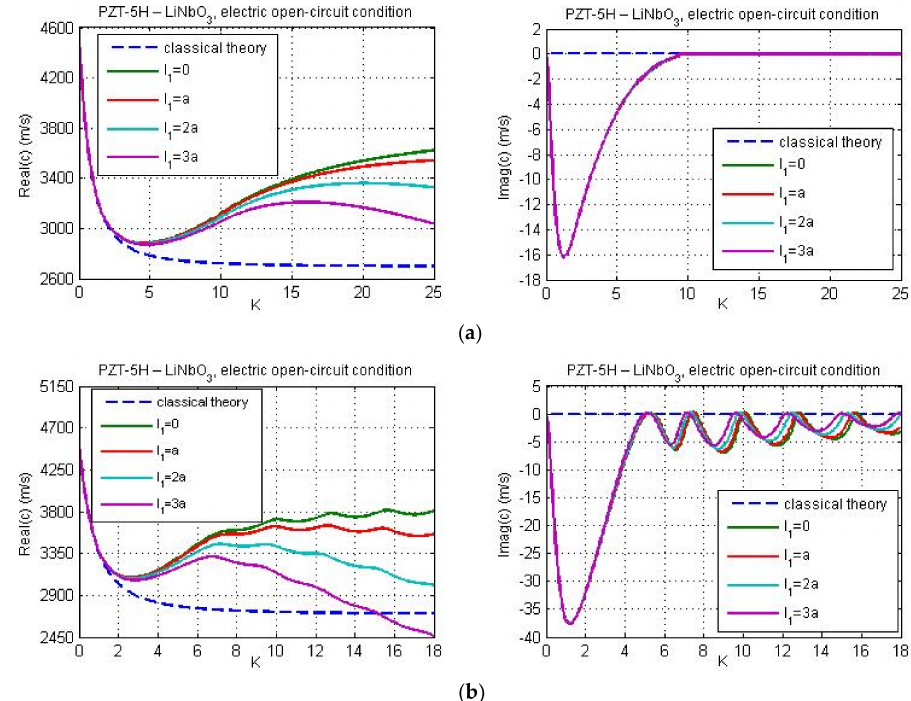
Figure 6. The real and imaginary parts of phase velocity c versus non-dimensional wave number K for different values of micro-inertia characteristic lengths in case of electric open-circuit conditions; guiding layer thicknesses: ( a ) 60 nm and ( b ) 25